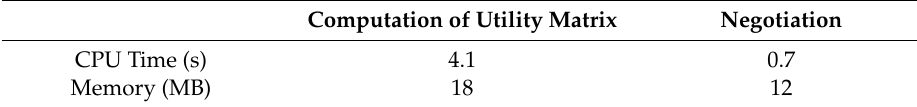
Table 2. CPU processing time and memory requirements for the simulations (in average).